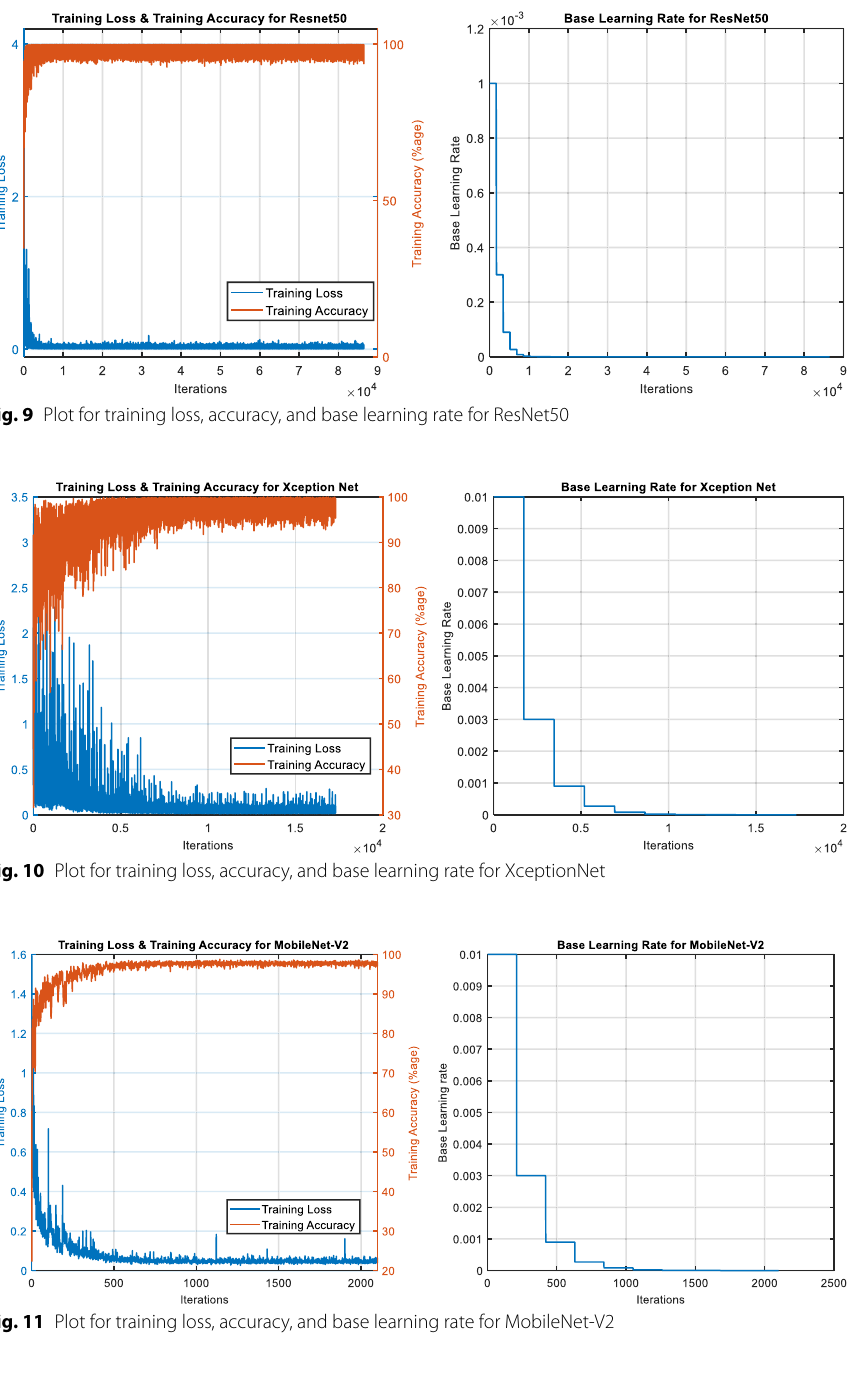
gives the comparison of the various performance metrics like global and mean accu- racy, mean and weighted IOU and mean BF score for the entire training, and test- ing and validation datasets for each designed network. Table 4 gives the information regarding the accuracy, IOU, and mean BF score for each class, i.e., with what preces- sion a particular class has been detected for the entire training, testing, and validation datasets for each designed network. Figures 12, 13, and 14 show the radar plot for